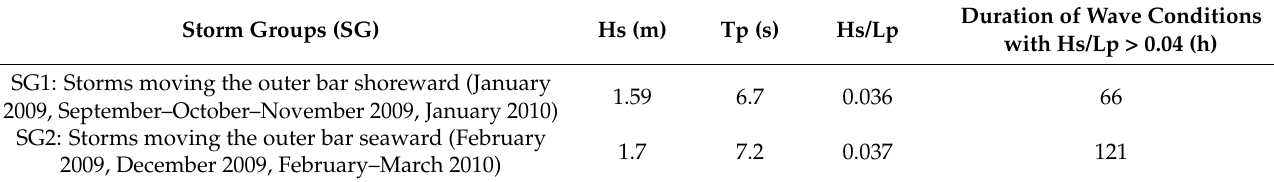
Table 2. Average wave parameters fulfilling the thresholds for scenarios S2&S4 for storms responsible for outer bar displacements. Storm Groups (SG) Hs (m) Tp (s) Hs/Lp